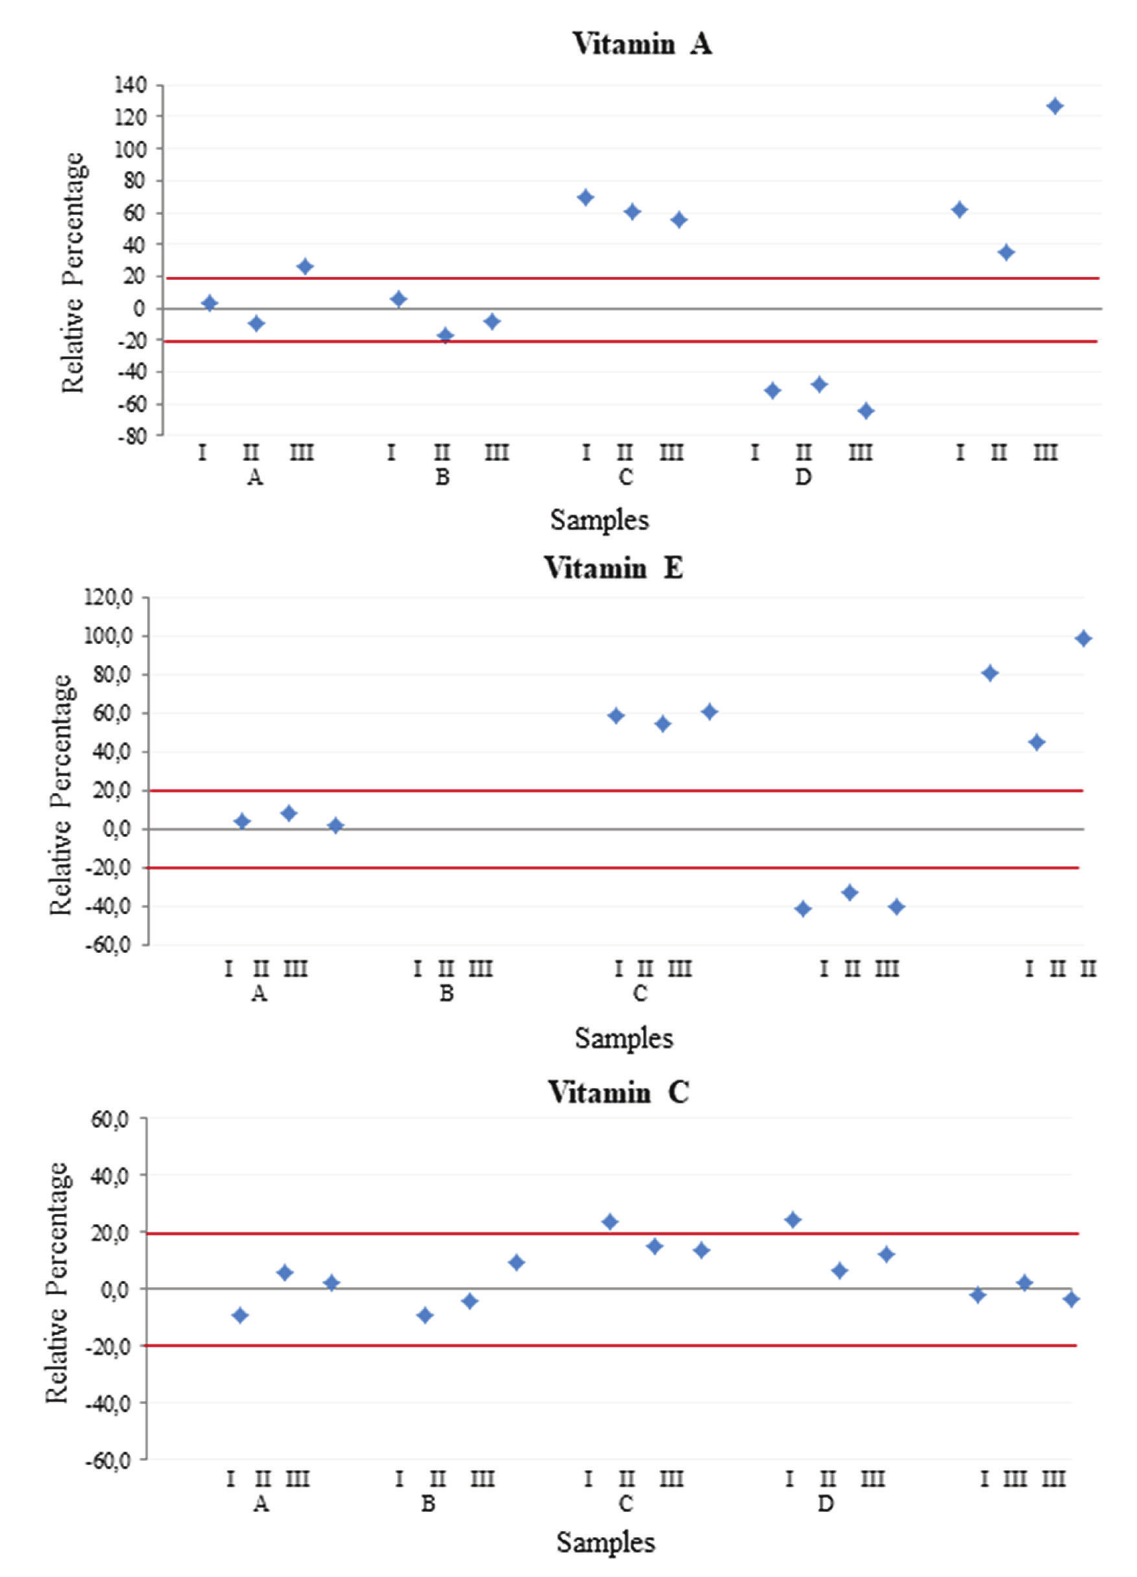
FIGURE 1 - Percentage of the relative variation of vitamins A, E, and C contents in the analyzed samples in relation to those declared on the label. Data in the area between red lines (-20 to 20): results in compliance with the legislation (i.e., samples whose difference between the analyzed and the declared value of vitamins are within the tolerance of